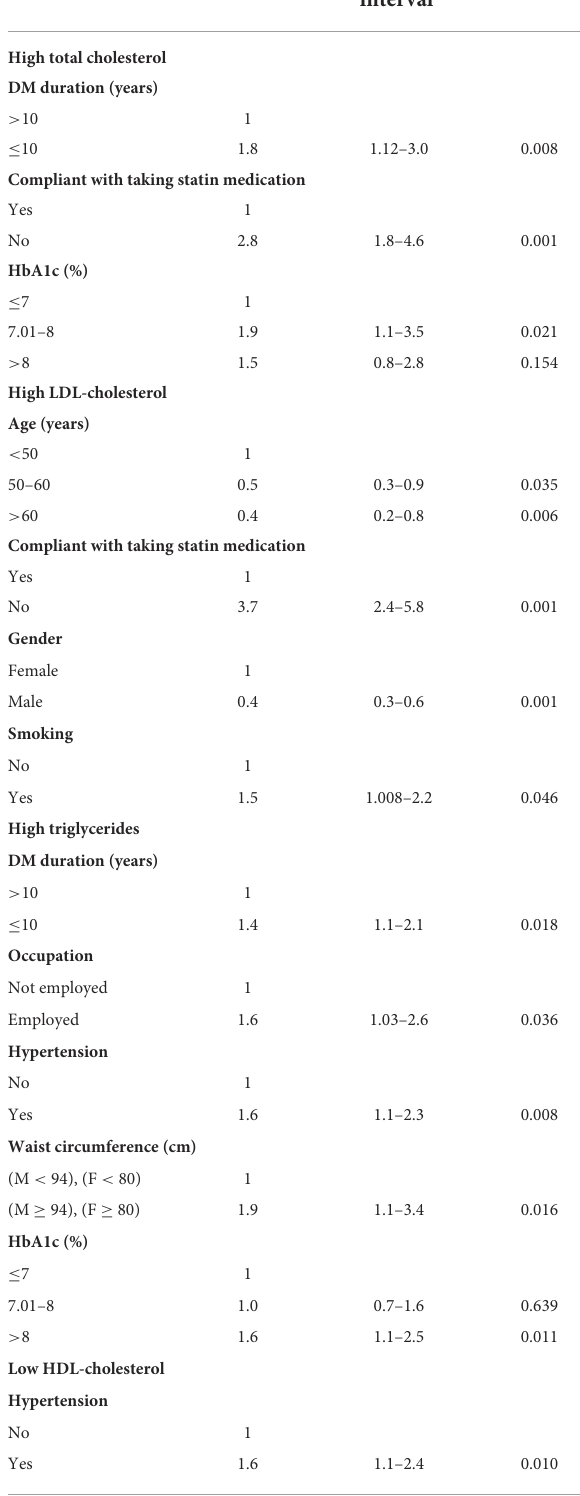
TABLE 4 Multivariate logistic regression analysis of the factors that are associated with high cholesterol, LDL and triglycerides, and low HDL. Odds